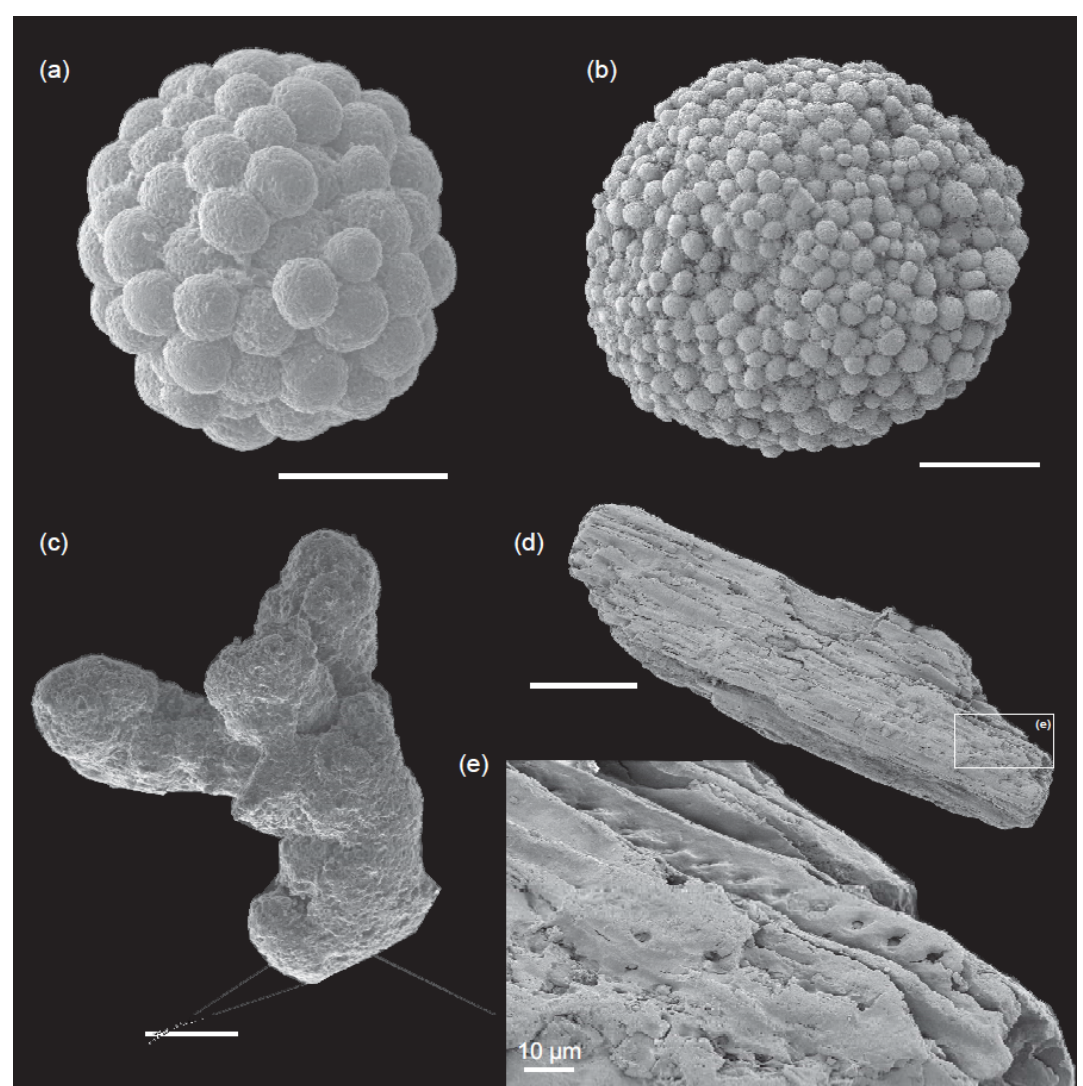
Figure 5. SEM images of mineralizations retrieved from the sieved samples of the thin-laminated dark marls. (a, b) Pyrite framboids. (c) Concretion of Mn oxy-hydroxide. (d, e) Coal wood fragment with preserved tracheid inner cavities and pit pores observed in the detailed view. Scale bar: